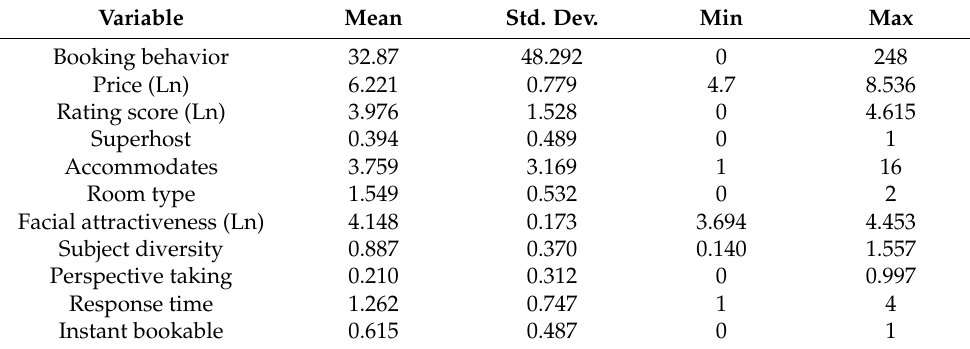
Table 3. Statistics of the variables.